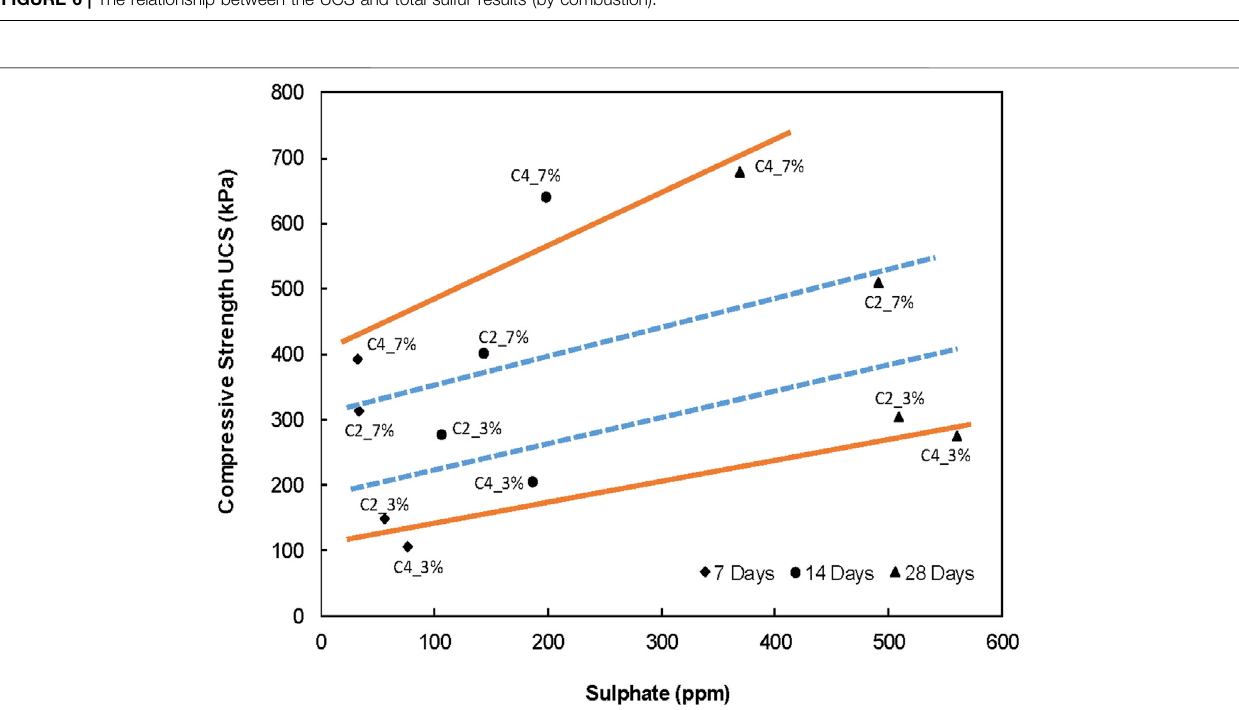
FIGURE 7 | The relationship between UCS and sulfate results (by ion